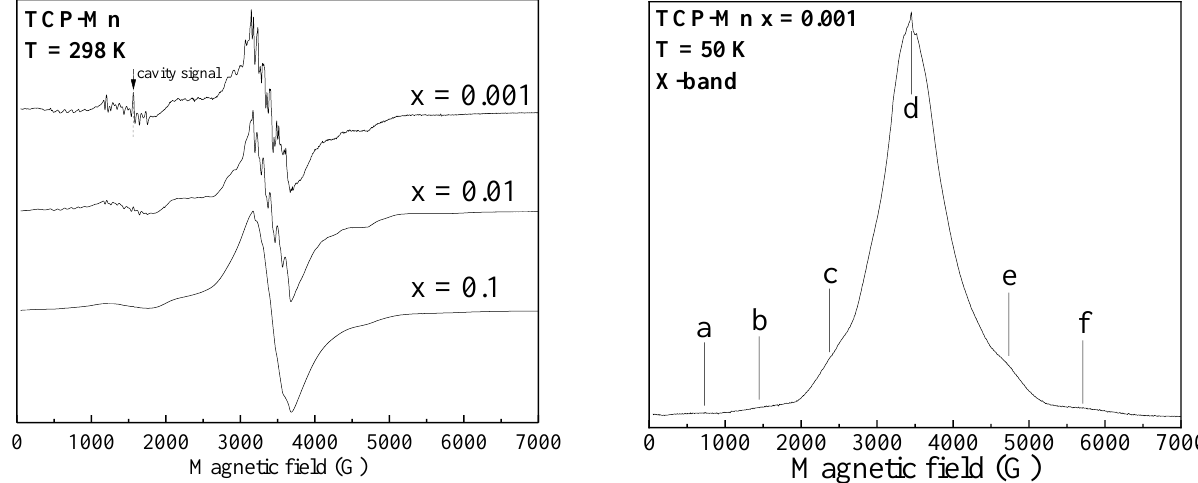
Figure 2. cw EPR at room temperature depending on the concentration of manganese ions embedded in the structure ( left panel ). ESE EPR for 0.001MnTCP; (a – f) denote the components of a fine structure ( right panel ).